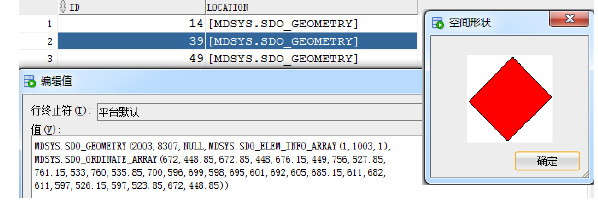
Figure 7. Select information from